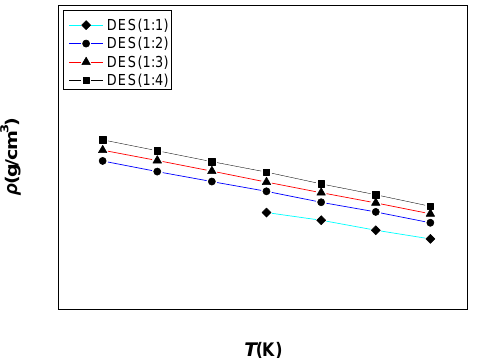
Figure 2. The change in experimental density with respect to temperature for the prepared DESs.